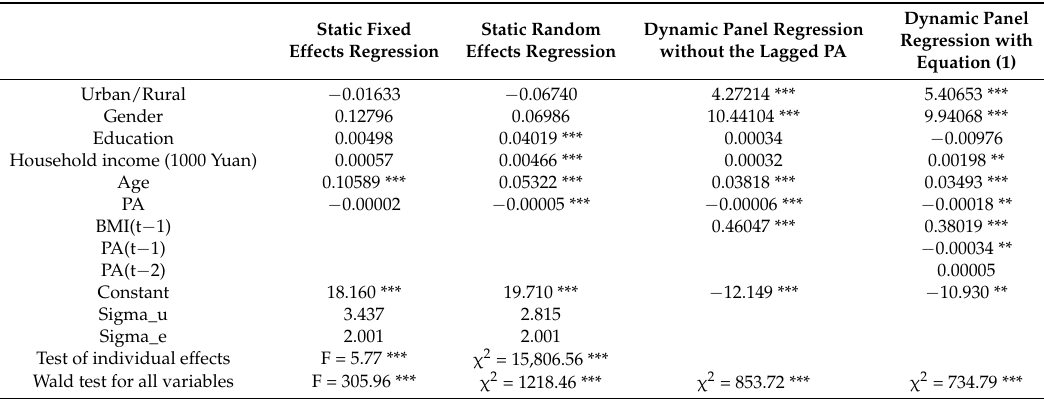
Table 4. Panel regression results for